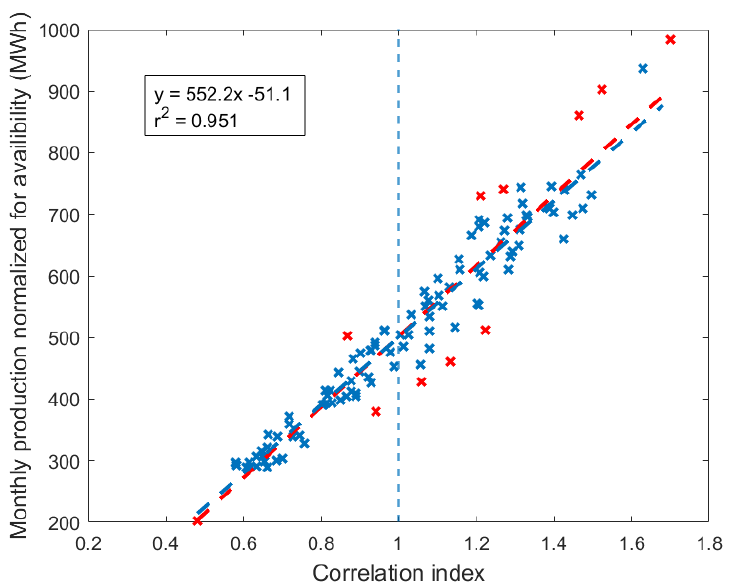
Figure 3. Monthly production plotted against the ERA5T correlation index for the corresponding months with the closest index site to one of the wind turbines. The red values have been excluded by the WCP filter.